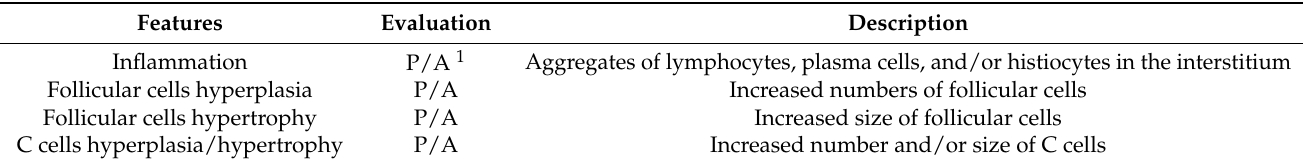
Table A10. Histopathological features evaluated in the thyroid gland.